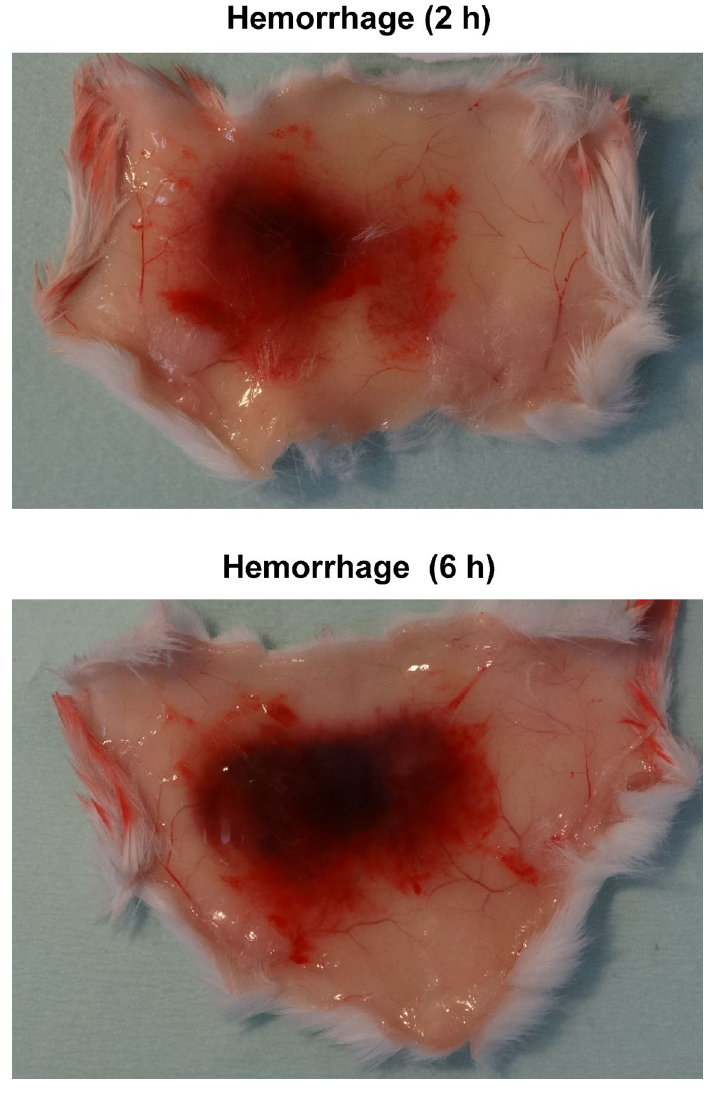
Figure 3. Representative images of hemorrhage generated in the mouse skin 2 h and 6 h after HF3 injection (1.0 μg in 50 mM HEPES, 1 mM CaCl 2 , pH 7.5), as described in “Materials and methods”.